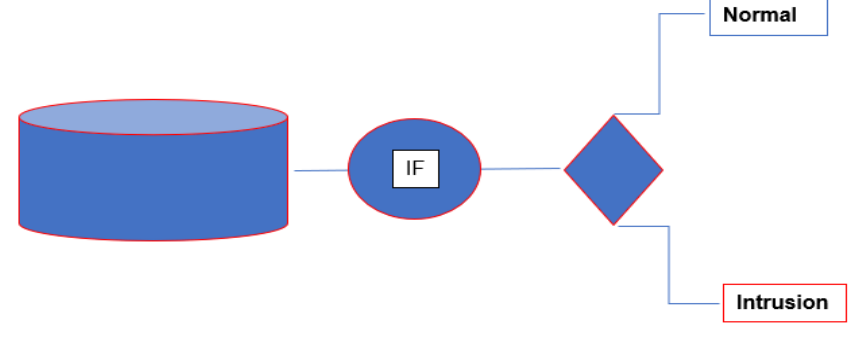
Figure 1. SIDS Figure 1. SIDS Model.